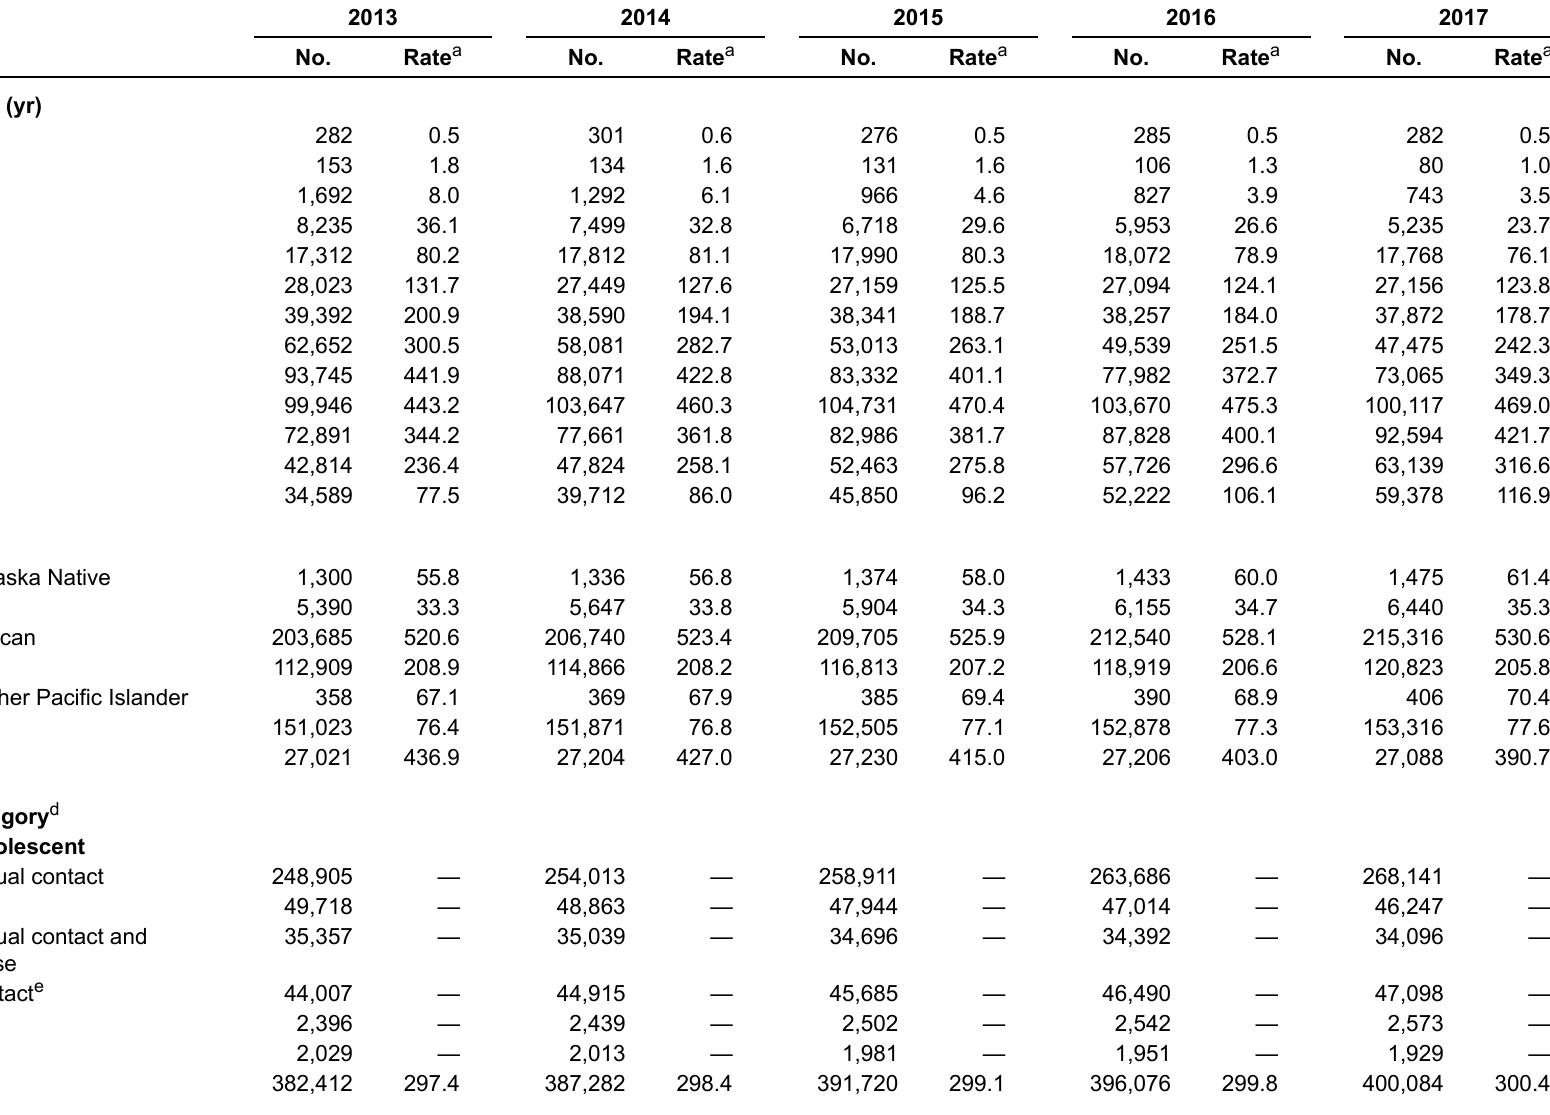
Table 23a. Persons living with diagnosed HIV infection ever classified as stage 3 (AIDS), by year and selected characteristics, 2013–2017—United